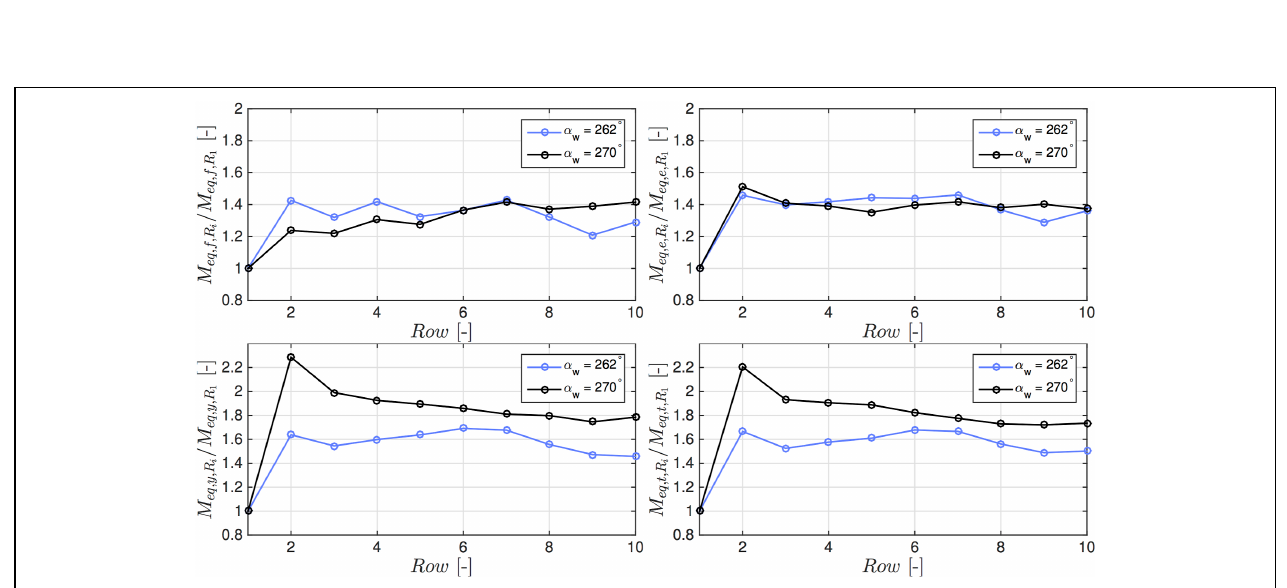
FIGURE 10 | M eq for the 10 rows, normalized by M eq of the first row of the line for the wind directions 262 ° and 270 ° .